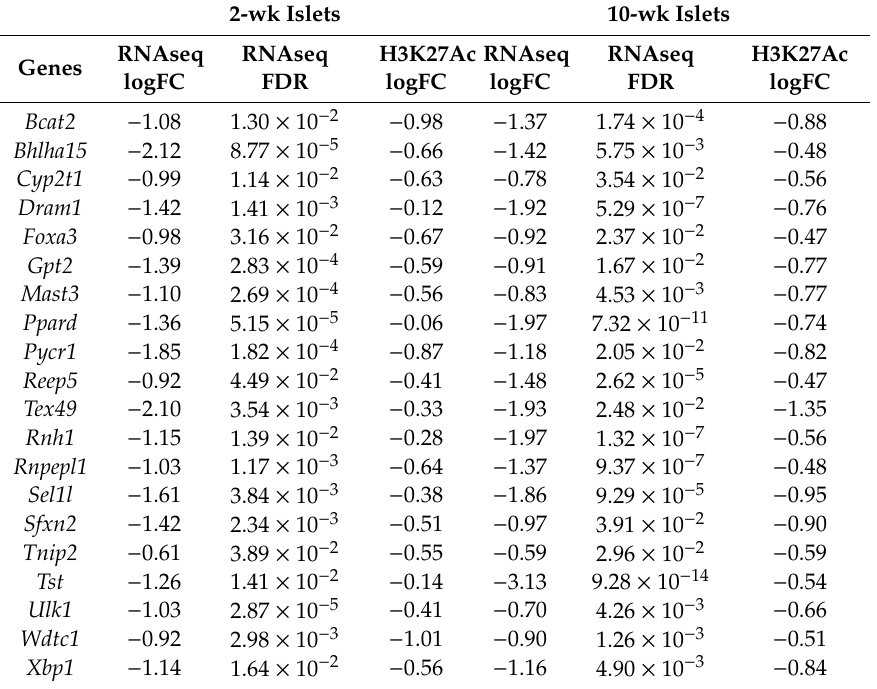
Table 3. Di ff erentially expressed genes with persistent changes for H3K27Ac histone mark. 2-wk